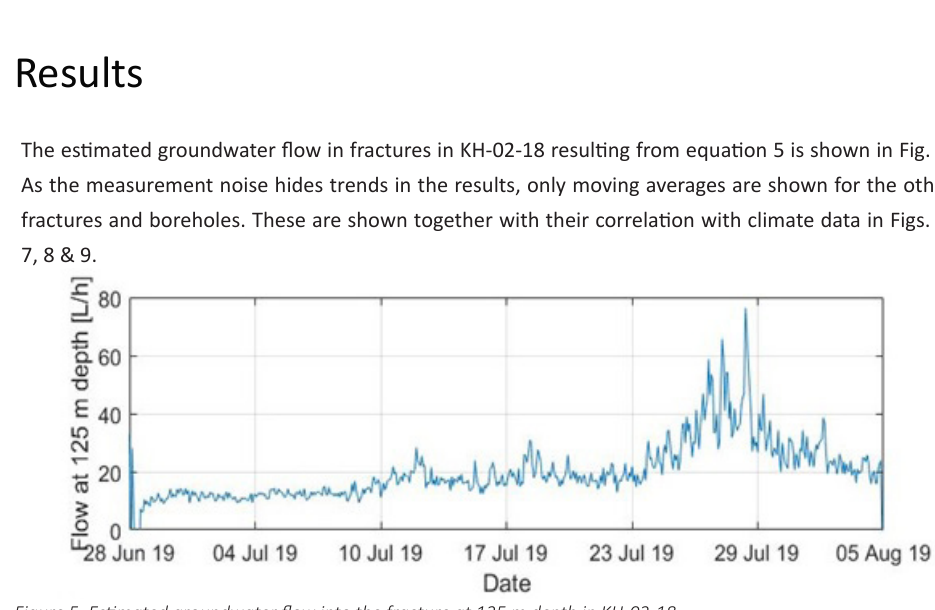
Figure 5. Estimated groundwater flow into the fracture at 125 m depth in